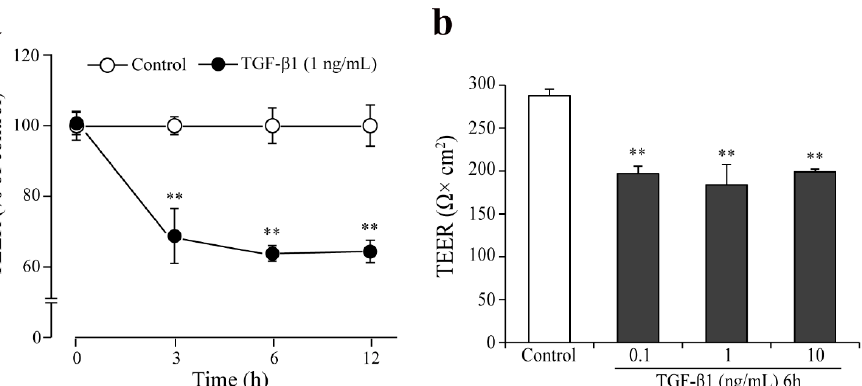
Figure 8. Effect of TGF- β 1 on barrier integrity in the monkey co-culture BBB model (EPA). ( a ) Effect of TGF- β 1 on the barrier integrity assessed by transendothelial electrical resistance (TEER) followed up to 12 h. ( b ) Effect of different concentrations of TGF- β 1 on the TEER (6-h treatment). All data are presented as means ± SEM (n = 3, ** p < 0.01 vs. control).